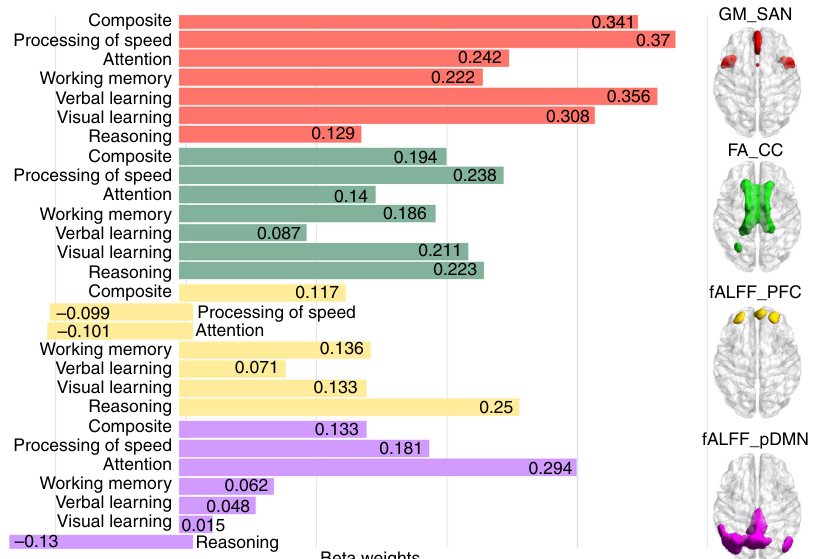
Fig. 8 Beta weights of GM_SAN, FA_CC, fALFF_PFC, and fALFF_pDMN in predicting multiple cognitive domains. GM_SAN and FA_CC have the higher contribution power for a majority of cognitive domains, while fALFF_pDMN and fALFF_PFC are more sensitive to re fl ect domain differences (higher standard